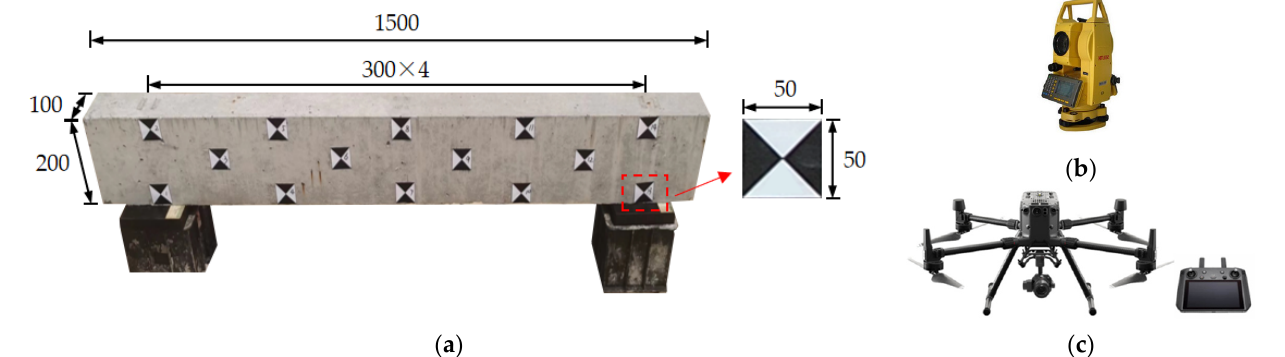
Figure 4. Test object and instrumentations: ( a ) simply-supported concrete beam (Unit: mm); ( b ) total Station Instrument; ( c ) UAV aerial photography system.